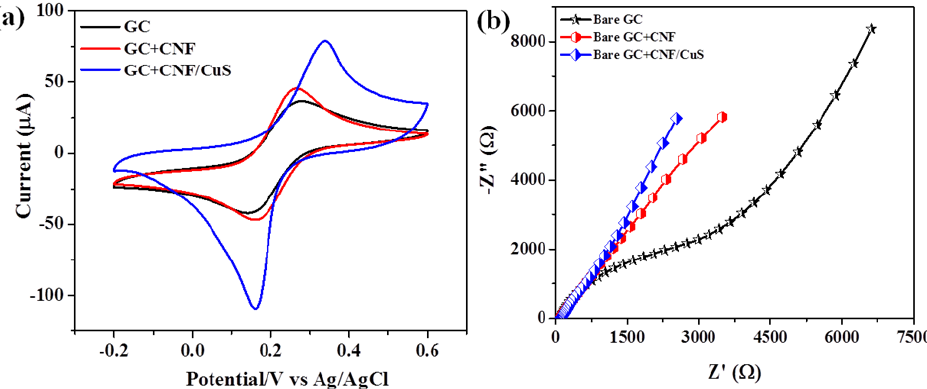
Figure 4. ( a ) CV curve at a scan rate of 50 mV s − 1 and ( b ) EIS spectra of different electrodes in 1 mM [Fe(CN) 6 ] 3 − /4 − in 0.1 M KCl solution.